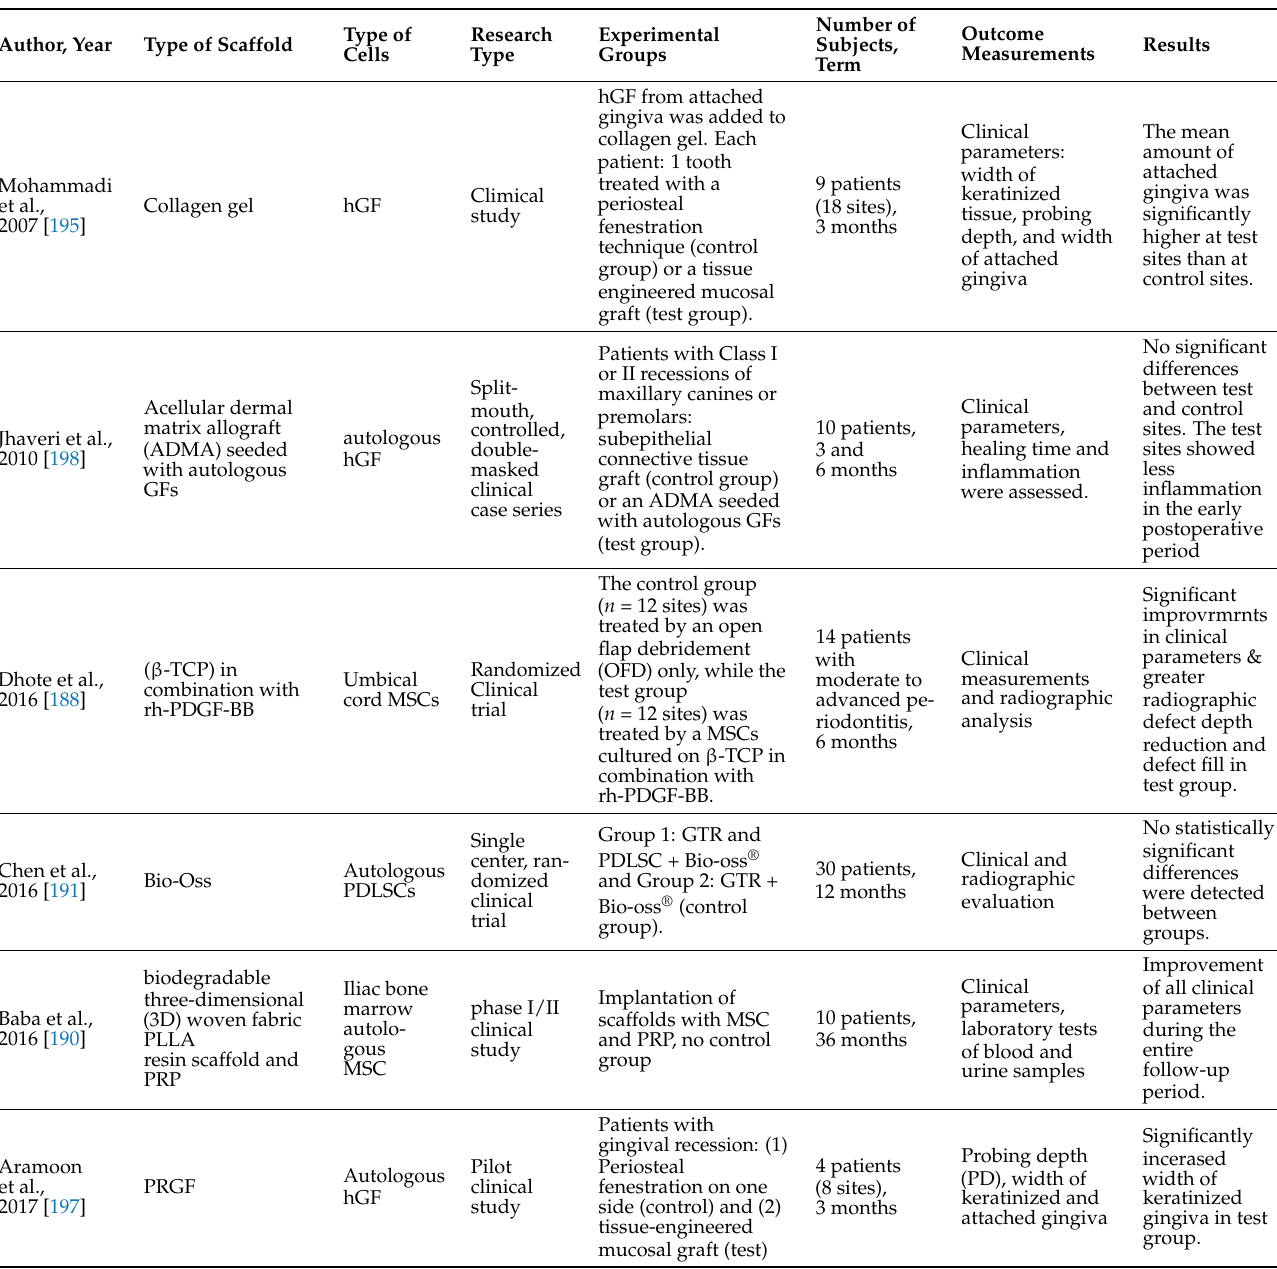
Table 4. Clinical studies involving cells and scaffolds for periodontal tissue